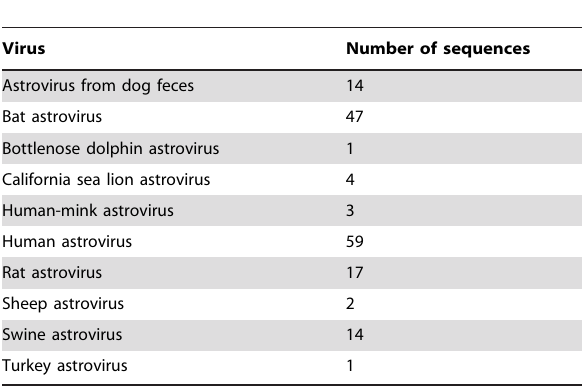
Table 4. Illumina sequences with remote homologies to